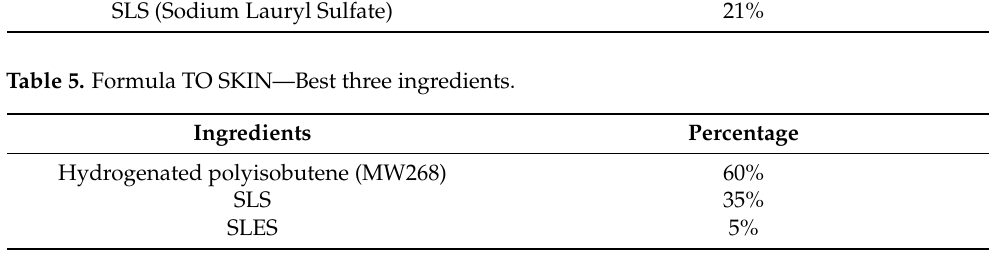
Table 6. Formula TO ACTIVE—Best three